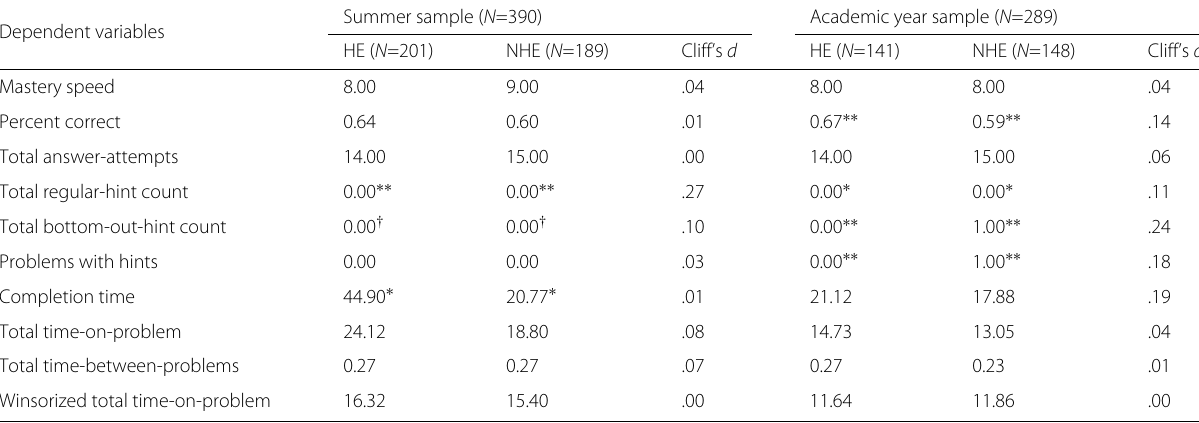
Table 5 Medians and effect sizes of performance- and temporal-based dependent variables by condition for both samples Dependent